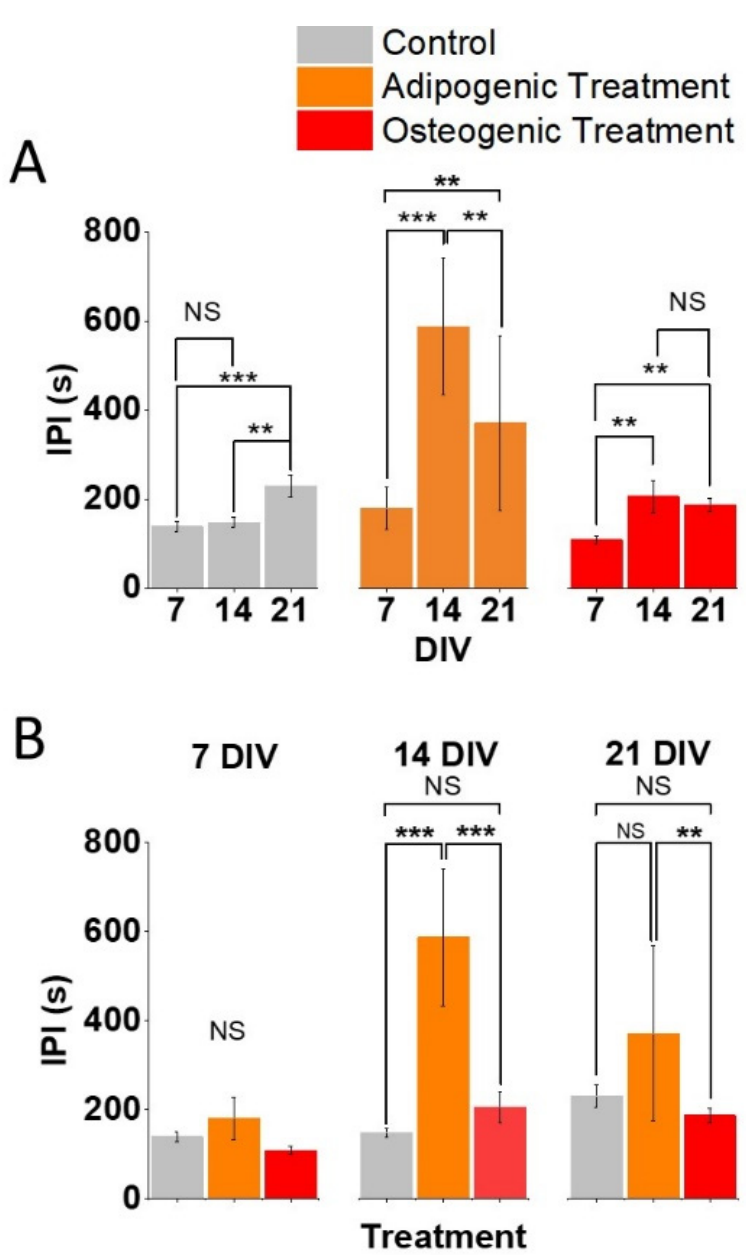
Figure 3. Both time and differentiation treatment affect the IPIs duration of spontaneous Ca 2+ oscillations. Untreated ASCs show increased interpeak intervals (IPI) at 21 days (( A ), left ), whereas cells exposed to adipogenic differentiation medium show an increase at 14 DIV and 21 DIV in comparison to 7 DIV, with a reduction at 21 DIV in comparison to 14 DIV (( A ), middle ). The osteogenic samples show an increase in IPI at 14 DIV and 21 DIV in comparison to 7 DIV, but no difference was observed between 14 DIV and 21 DIV (( A ), right ). No difference in the IPI was observed across treatments at 7 DIV (( B ), left ). The adipogenic sample showed IPIs which were longer than those of controls and the osteogenic sample at 14 DIV (( B ), centre ). Finally, at 21 DIV the adipogenic sample showed longer IPIs in comparison to those observed in the osteogenic one, but no difference was observed between controls and either treatment (( B ), right ). Multiple pairwise comparisons were carried out with t-test with Bonferroni correction: *** = p ≤ 0.001, ** = p < 0.05.